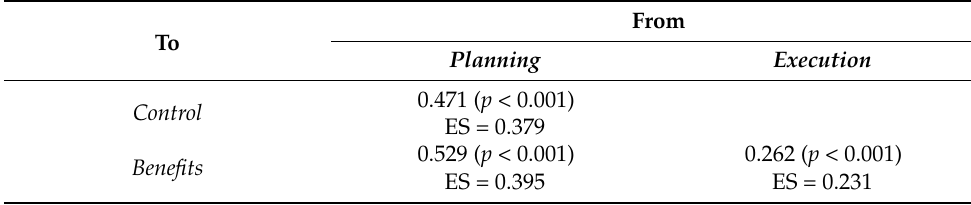
Table 7. Sum of indirect effects (two segments).